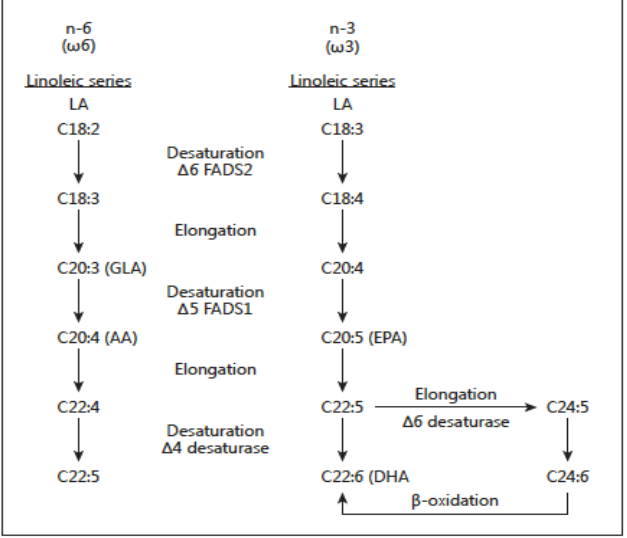
Figure 3. Desaturation and elongation of ω -3 and ω -6 fatty acids by the enzymes fatty acid de-saturases FADS2 (D6) and FADS1 (D5).